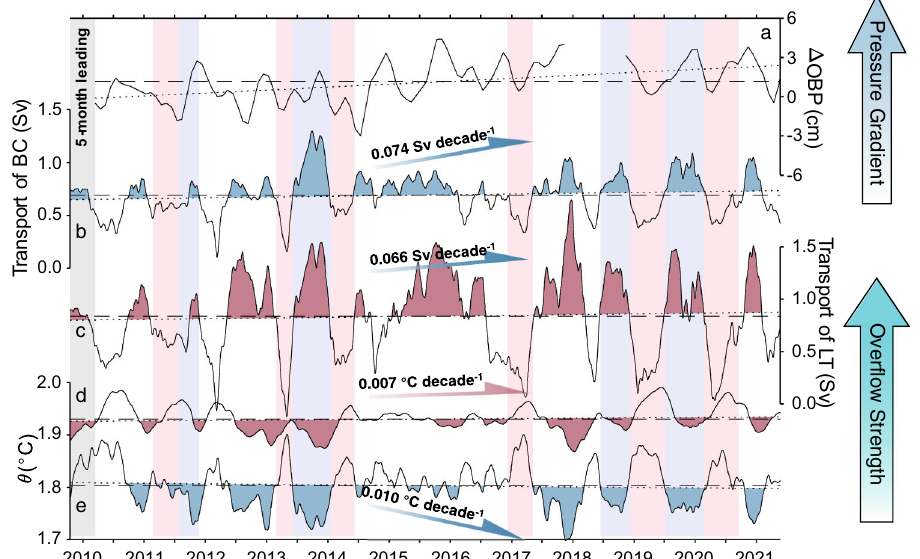
Fig. 4 | Trends of the Luzon Strait over fl ow. a Ocean Bottom Pressure (OBP) change from the Gravity Recovery and Climate Experiment (GRACE) between the South China Sea (110 – 120°E, 10 – 20°N) and the Paci fi c Ocean (122 – 130°E, 16 – 24°N) and observed transport and potential temperature ( θ ) time series of BC (in blue ( b , e )) and LT (in red ( c , d )), with shading showing over fl ow-enhanced periods, all series are 120-day lowpassed. Background color in light blue (red)